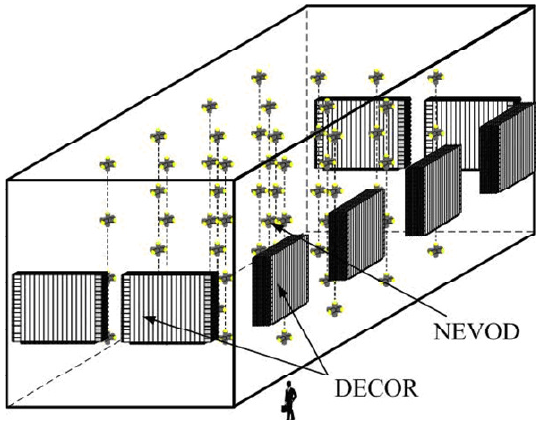
Figure 1. Experimental complex